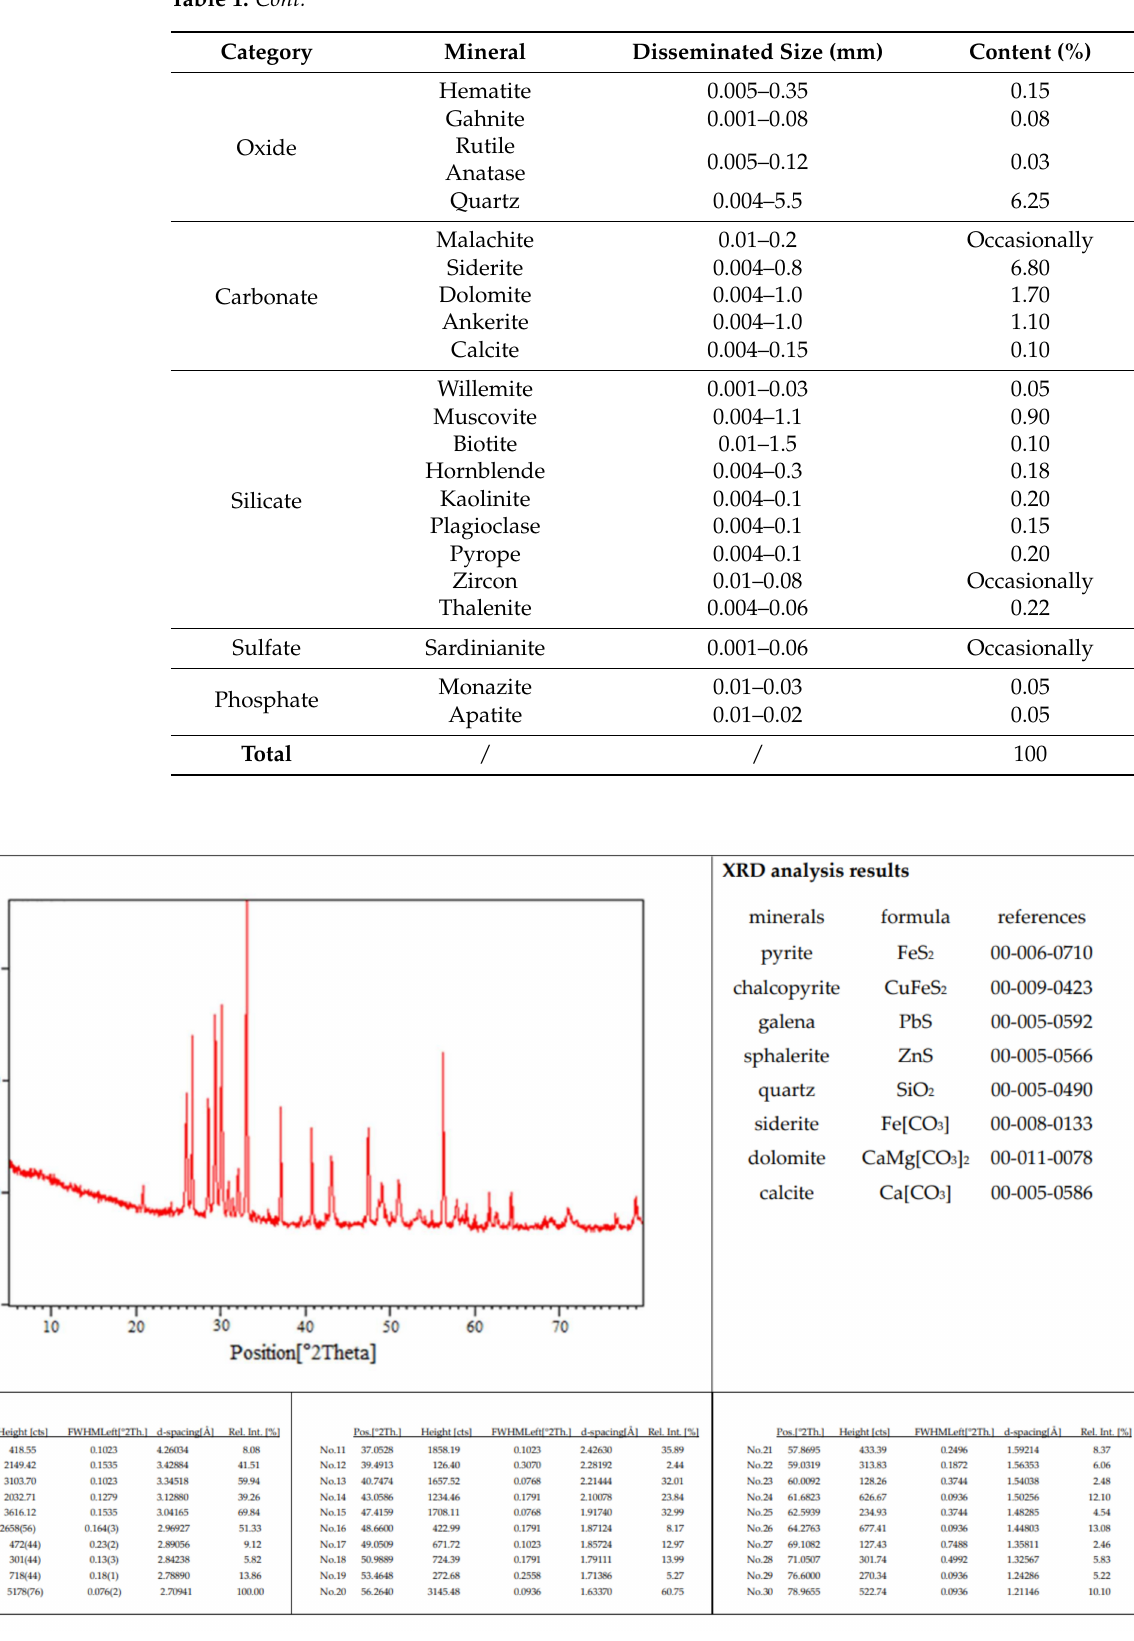
Figure 1. Results of XRD of ore